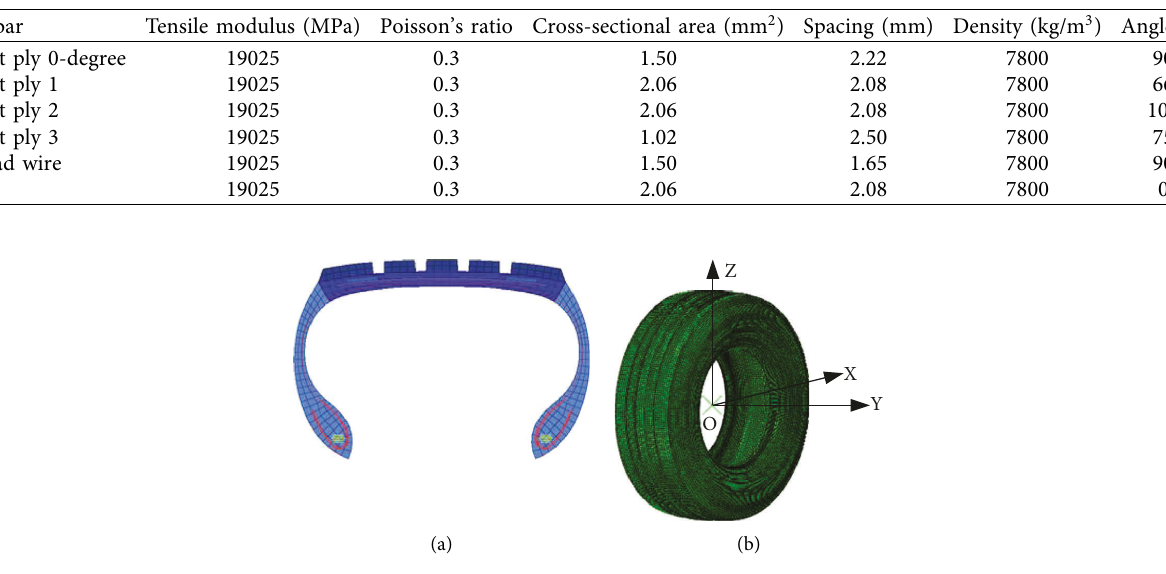
Table 3: Rebar parameter setting.